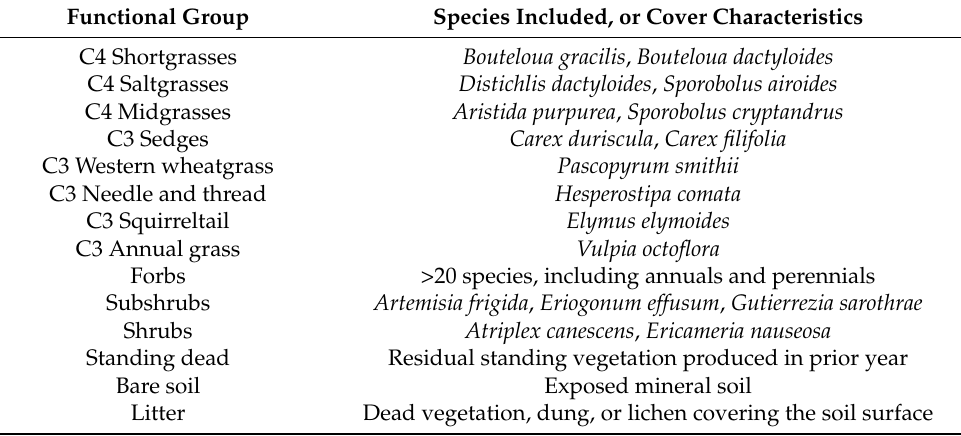
Table 1. The twelve plant functional groups used in a cluster analysis to identify distinct plant communities to be mapped using hyperspectral imagery at the Central Plains Experimental Range in northeast Colorado. Functional Group Species Included, or Cover Characteristics